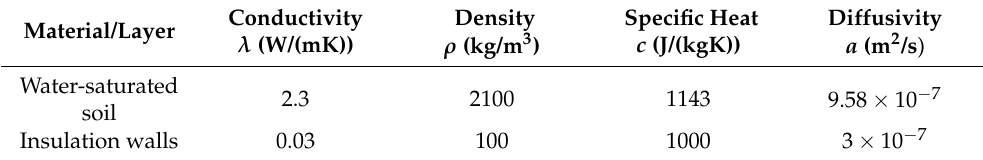
Table 3. Thermophysical properties of the materials involved for the synthetic